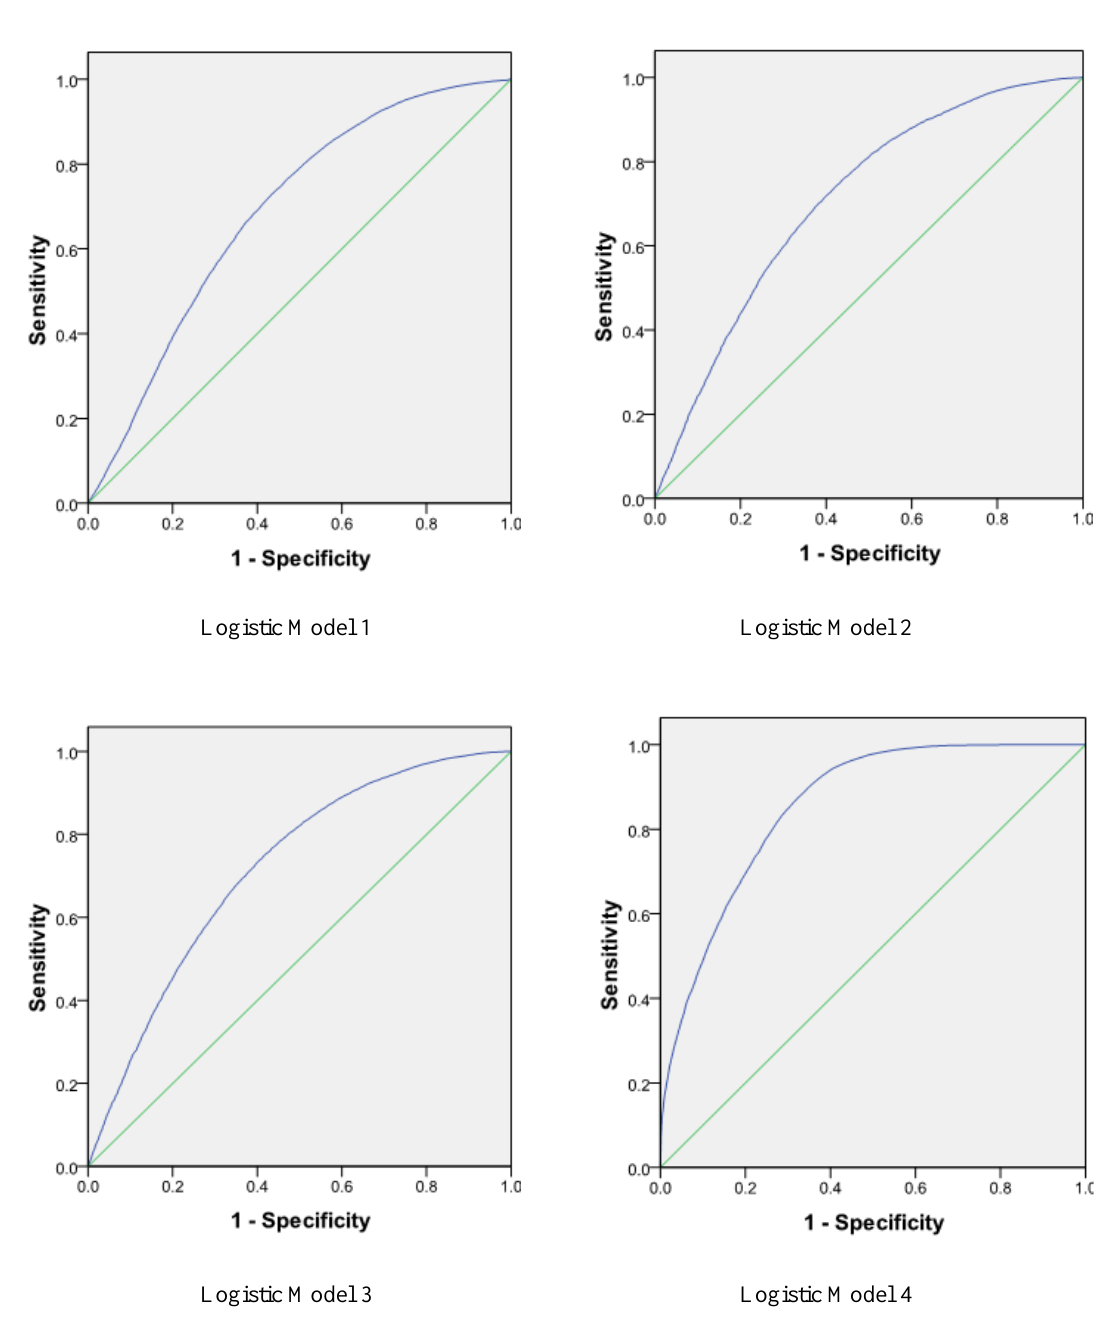
Figure 1. ROC graphs of Logistic Regression